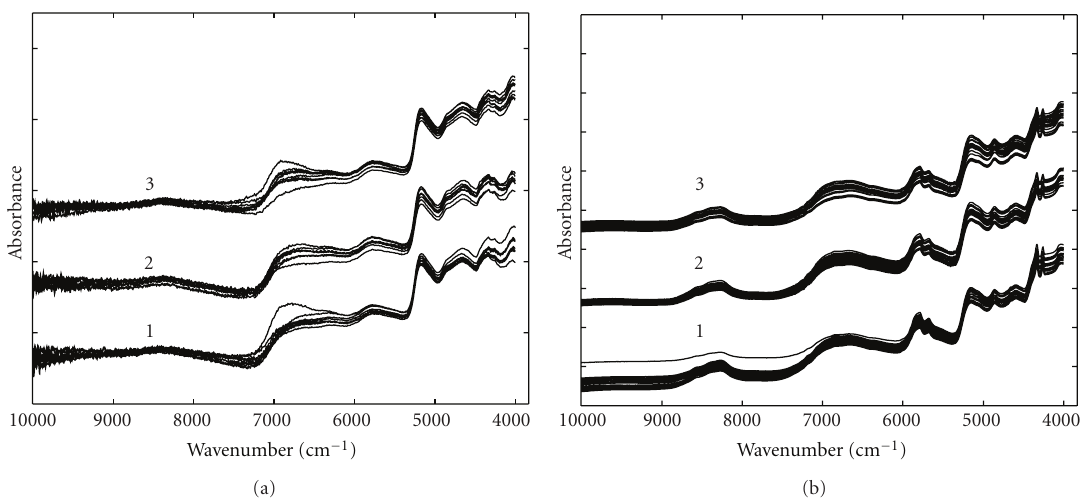
Figure 1: Some of the raw NIR spectra of cotton leaves (a) and seeds (b). The genotypes were (1) parent 222, (2) transgenic 07-19, and (3) hybrid